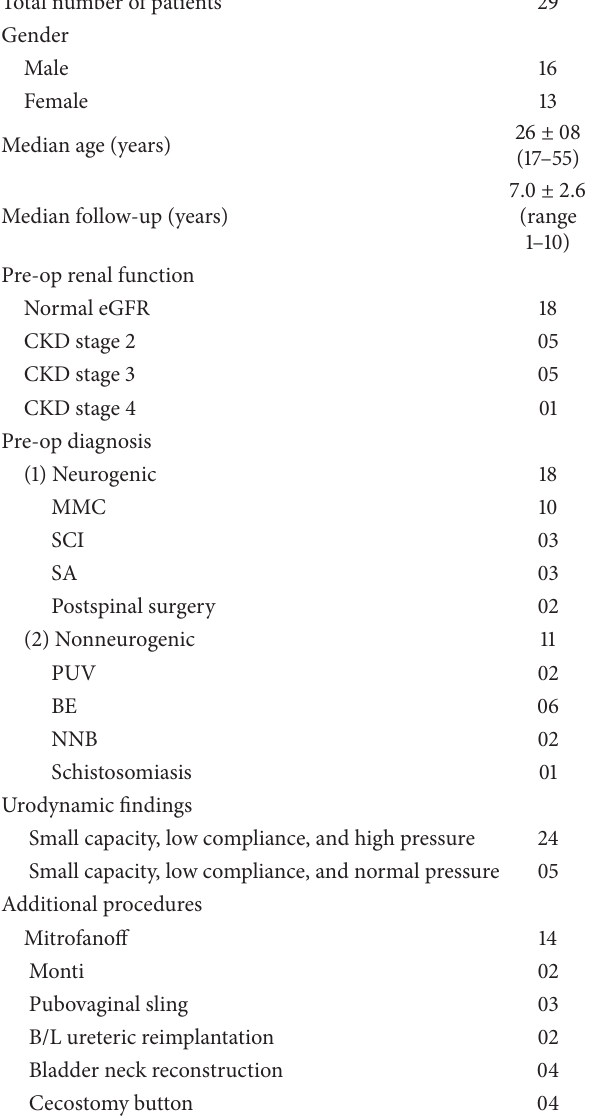
Table 1: Demographic data. Table 2: Categorization of patients on the basis of eGFR.